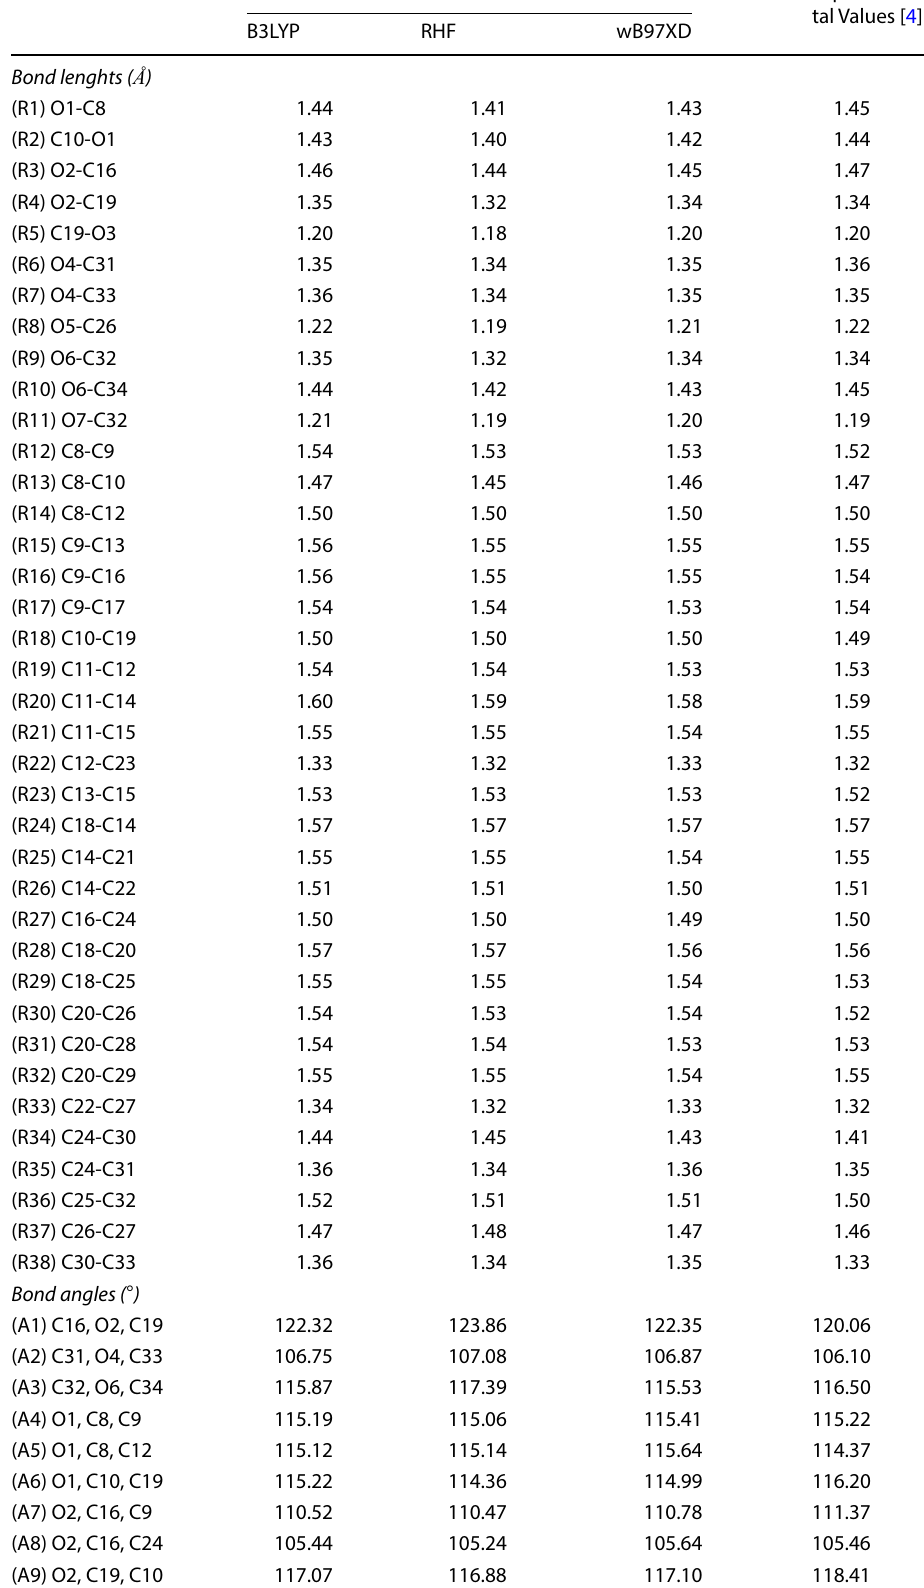
Table 1 Comparison between geometric, experimental and calculated parameters by B3LYP, RHF and wB97XD with 6–311 G(d,p) basis set of